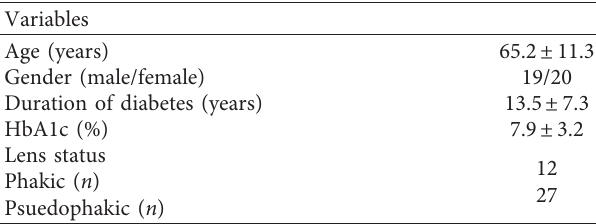
Figure 1: Swept-source optical coherence tomography radial scan (9mm) of a patient with diabetic macular edema and subfoveal neuroretinal detachment showing structural biomarkers evaluated within a 3mm area centered on the fovea: CT: choroidal thickness; SRD: serous retinal detachment; EZ: ellipsoid zone integrity; IRC: intraretinal cysts; HRS: hyper-reflective spots; VMA: vitreomacula adhesion. Table 1: Clinical characteristics of the study